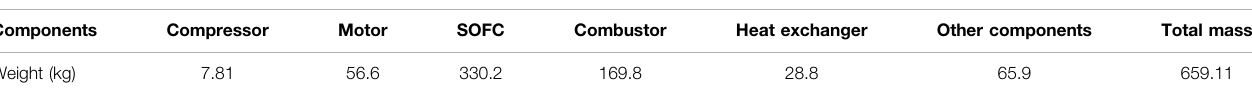
TABLE 6 | Estimated component mass of HEFC